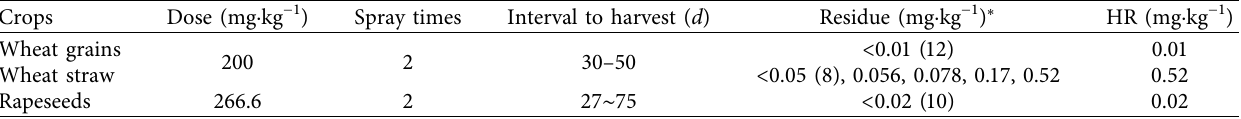
Table 3: The terminal residues of phthalanilic acid in wheat grains, wheat straw, and rapeseeds. Crops Wheat